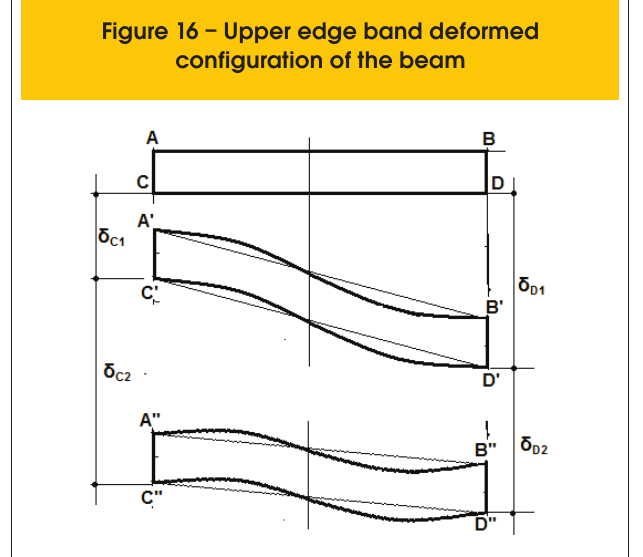
Figure 16 – Upper edge band deformed configuration of the